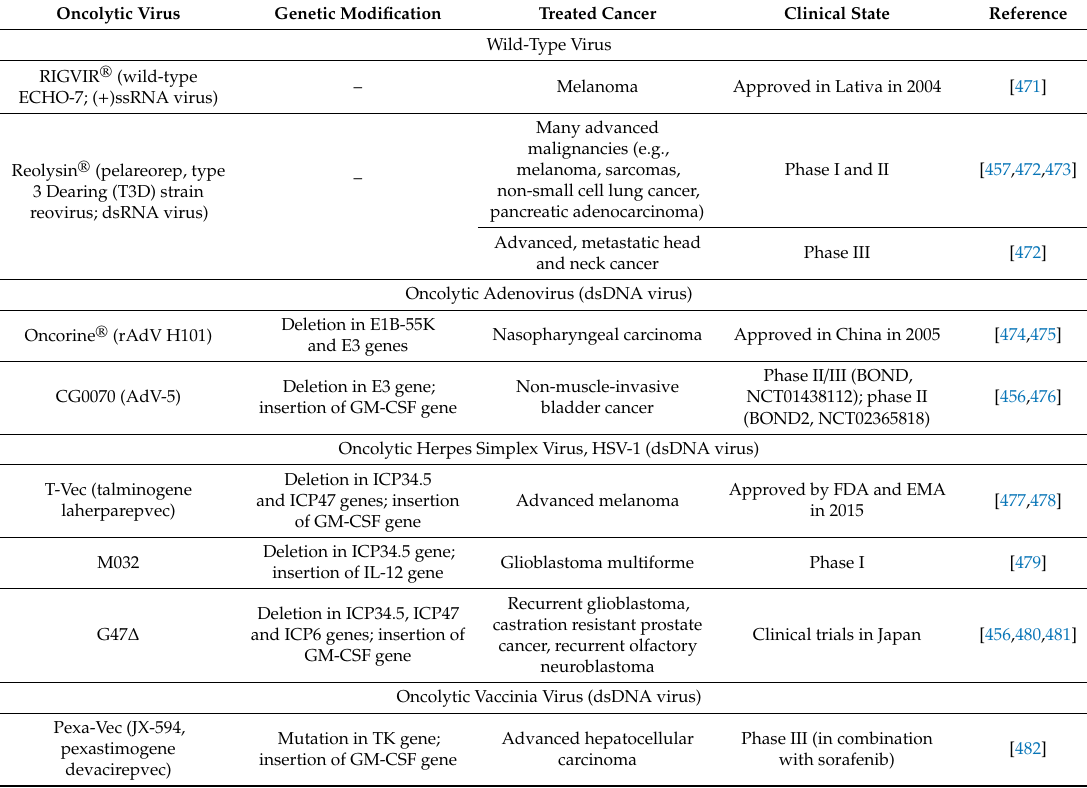
Table 2. Examples of oncolytic virotherapies approved or in clinical